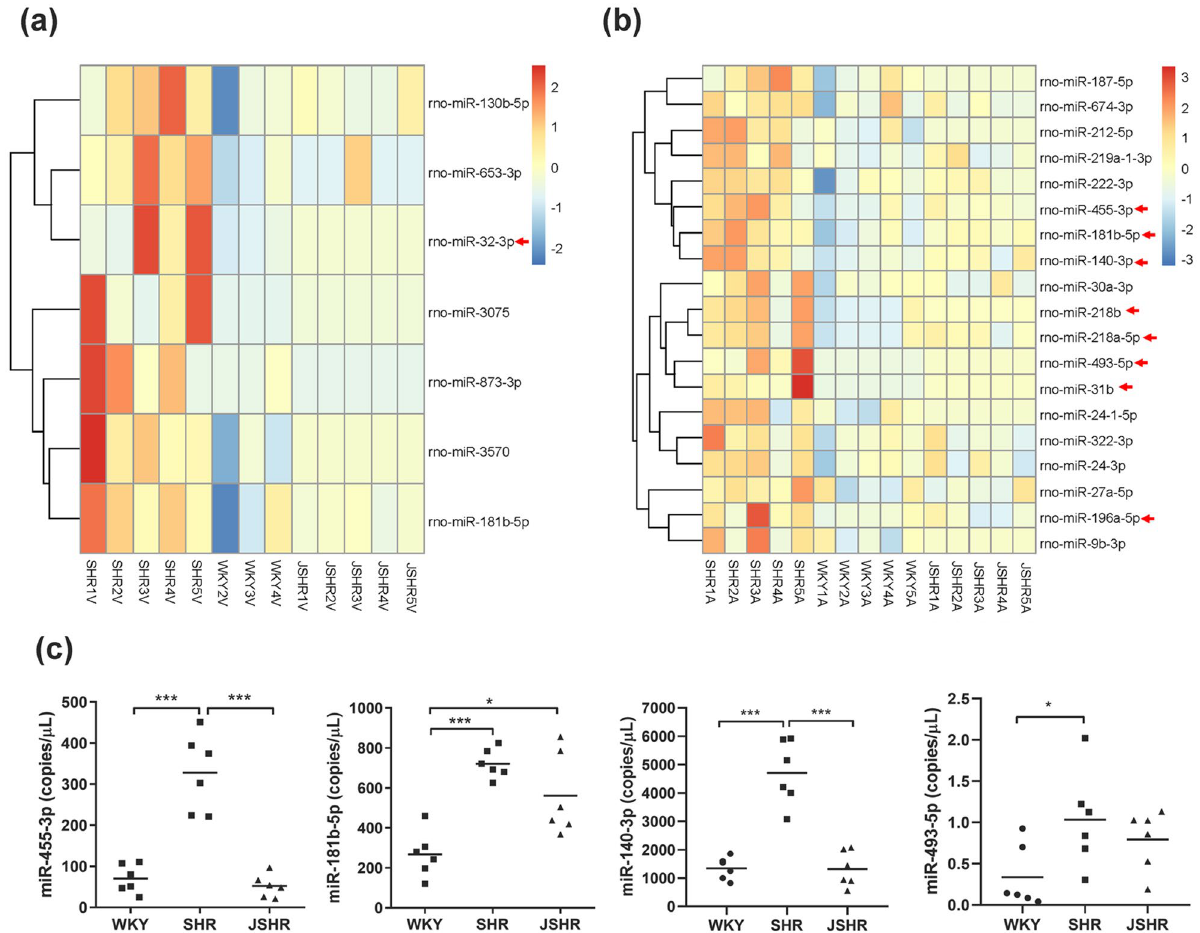
Figure 4. Elevated arterial circulating microRNAs might be potential biomarker for hypertension. ( a , b ) Overlaps of deregulated miRNAs from SHR-vs-JSHR comparison and SHR-vs-WKY comparison in venous blood samples ( a ) and arterial blood samples ( b ). The heatmap shows all of the shared miRNAs. Note that batch effect correction was applied to combine the expression profiles of SHR/WKY groups and that of the JSHR group (because JSHR was sequenced in another batch). As the result, the differentially expressed in this analysis should be differed from the previous SHR-vs-WKY comparison. Nevertheless, 9 miRNAs are shared with the previous analysis (8 from arterial blood and 1 from venous blood), and these 9 miRNAs are highlighted by red arrows aside the heatmaps. ( c ) Droplet digital PCR quantification of rno-miR-455-3p, rno-miR-181b-5p rno- miR-140-3p and rno-miR-493-5p in arterial plasma of 6 WKY, 6 SHR and 6 JSHR rats. *P < 0.05, ***P <